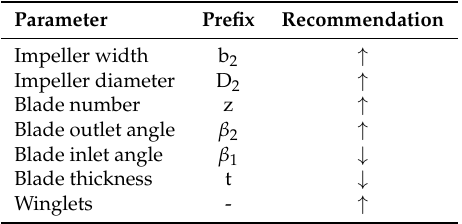
Table 5. Design recommendations for the impeller of a vortex pump.